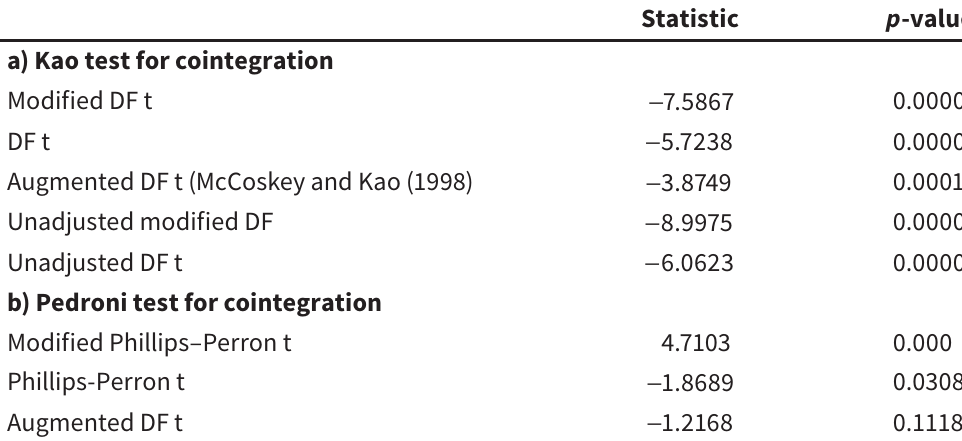
Cointegration test